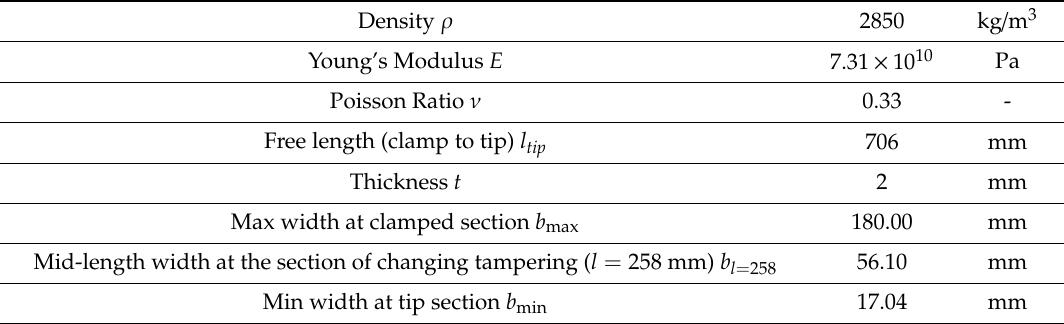
Table 1. Geometrical and mechanical properties of the wing